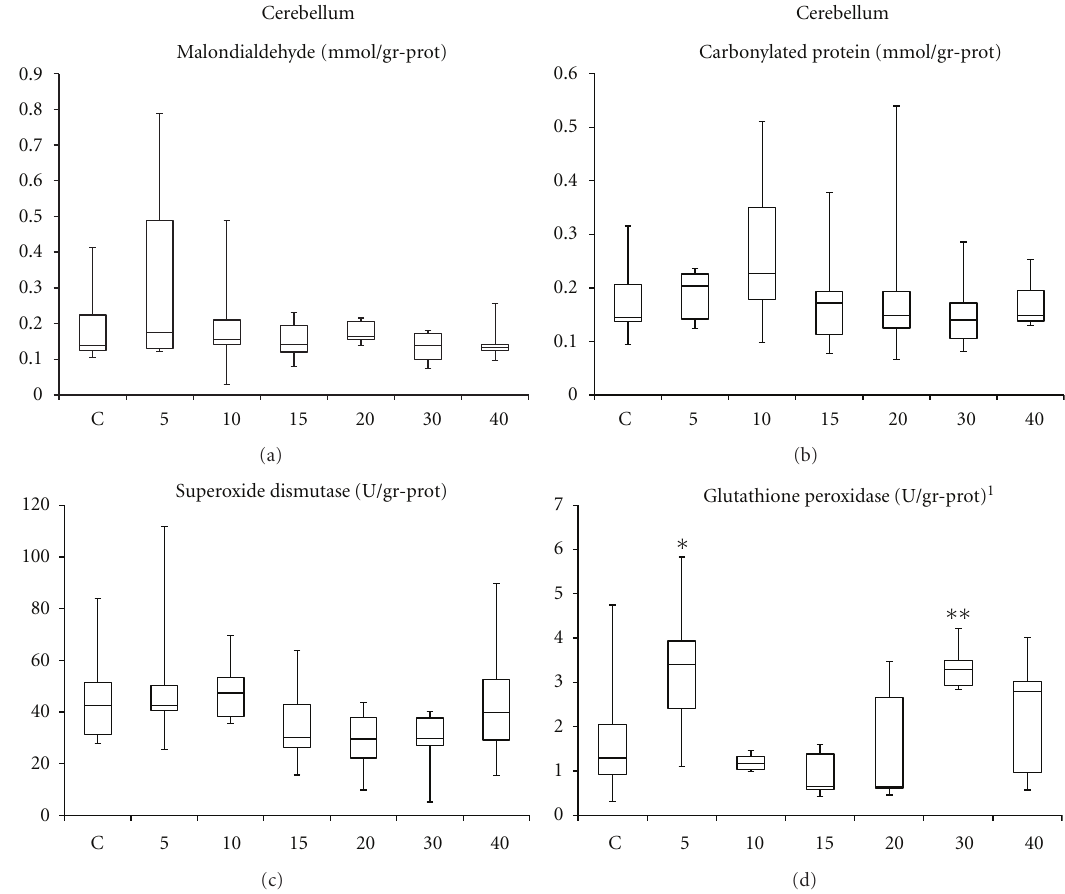
Figure 3: Cerebellar values of oxidation products and antioxidant enzymes activities. C: control group; numbers on the x -axis stand for the HBO 2 session number of the groups. One way ANOVA : 1 P < 0 . 001. Bonferroni : ∗ P = 0 . 009 and P = 0 . 004, ∗∗ P = 0 . 01 and P = 0 . 004 versus 10- and 15-exposure groups, respectively. Comparisons with the control groups resulted in comparable